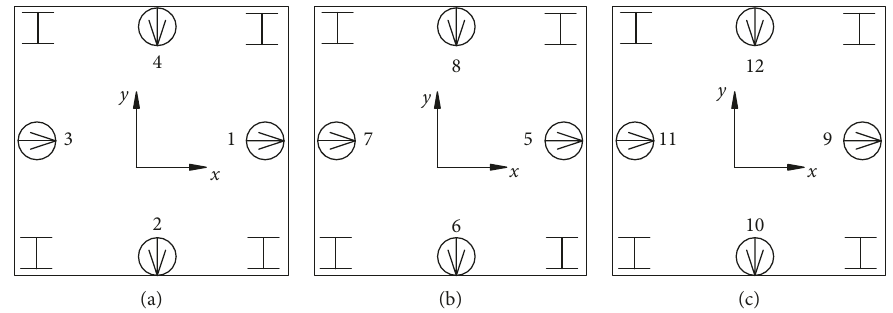
Figure 11: Arrangement of acceleration transducers. (a) At bottom of first floor. (b) At bottom of second floor. (c) At top of second